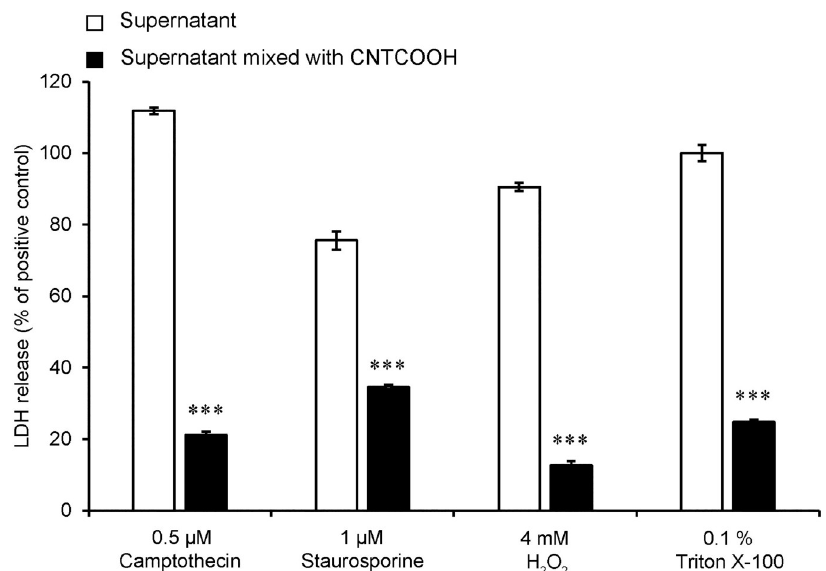
Fig 7. CNTCOOH NPs interfere with the LDH assay. HUVECs were treated with 0.5 μ M camptothecin, 1 μ M staurosporine, 4 mM H 2 O 2 or 0.1% Triton X-100 for 24 hours to induce LDH release. After the treatment, the media were collected and centrifuged and the supernatant was divided into two aliquots. One aliquot was mixed with 100 μ g/ ml of CNTCOOHs and the other was left as a control. The presence of active LDH was measured colorimetrically. Data measured in 4-plicates (n = 3) are presented as the means ± SEM as tested by the two-tailed unpaired t-test, where ��� P < 0.001 versus the